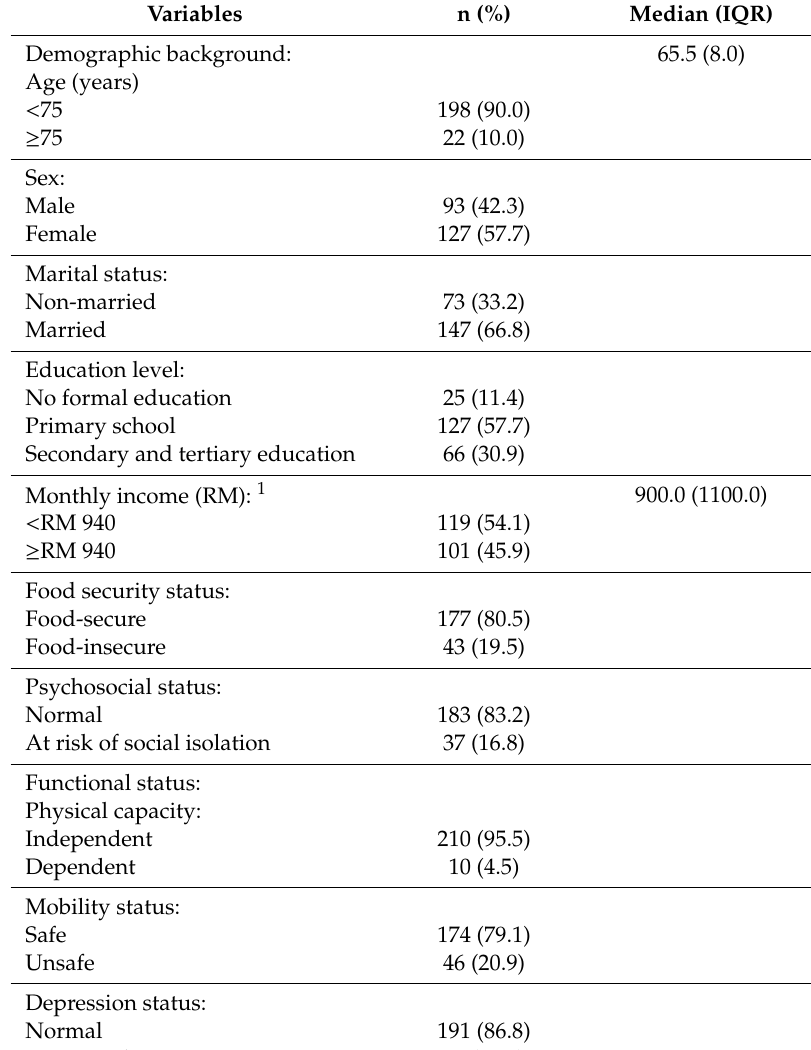
Table 1. Characteristics of the